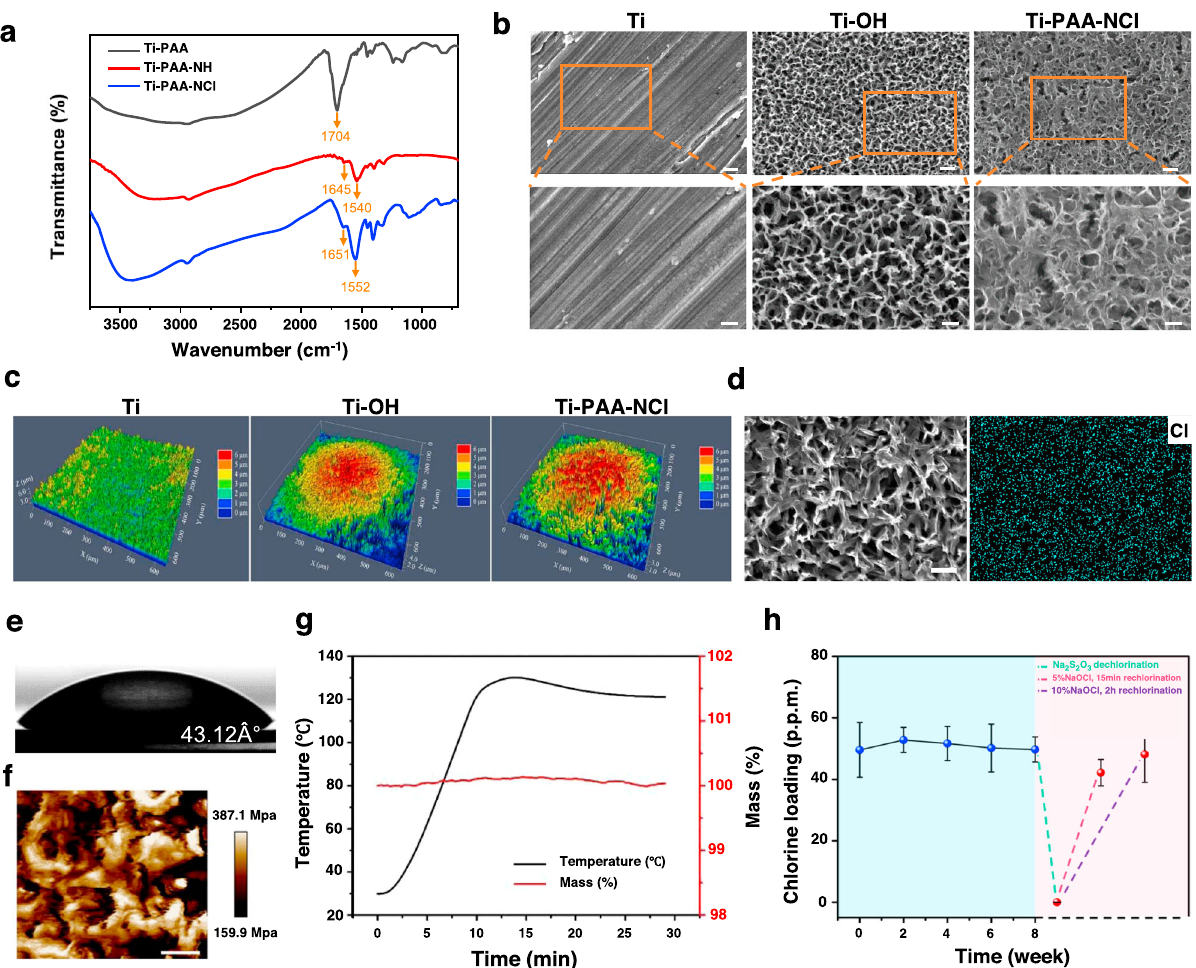
Fig. 2 Structure characterization of the porous N-halamine polymeric coating on the titanium surface. a FTIR spectra of Ti-PAA, Ti-PAA-NH and Ti- PAA-NCl. b SEM images showing the surface morphology of Ti, Ti-OH and Ti-PAA-NCl (upper scale bars = 400nm, lower scale bars = 200 nm). c CSLM images of the surface roughness of Ti, Ti-OH and Ti-PAA-NCl. d Elemental mapping of Ti-PAA-NCl showing the homogeneous distribution of Cl in the pore wall of N-halamine polymeric coating (scale bar = 5 μ m). e Water contact angle of Ti-PAA-NCl. f Young ’ s modulus mapping via AFM for the N- halamine polymeric coating of Ti-PAA-NCl (scale bar = 200 nm). g TG curve of Ti-PAA-NCl showing good thermal stability. h Storage stability and regeneration of oxidative Cl + for Ti-PAA-NCl ( n = 3). The pink part gives the Cl + contents of the dechlorinated and rechlorinated products of Ti-PAA-NCl with 8 weeks of storage. Error bars =